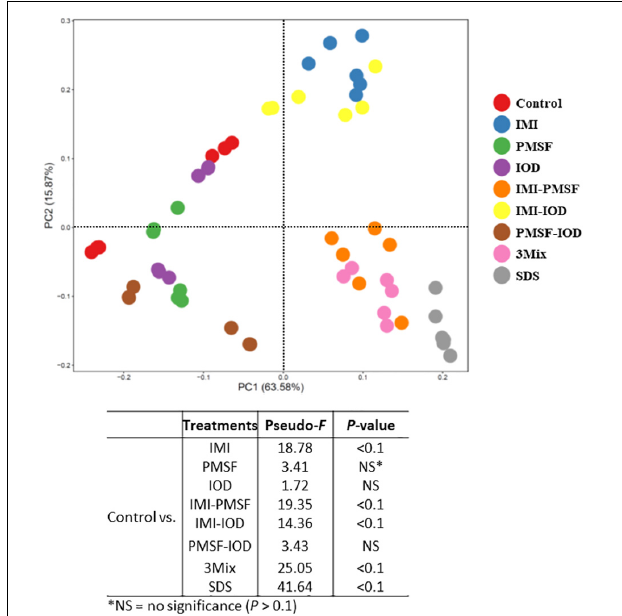
FIGURE 2 | Principal components analysis (PCA) of the predicted functional features (based on KEGG orthologs and the CowPI database). PERMANOVA results of the pairwise comparison of the overall functional structures between control and each of inhibitor treatment was